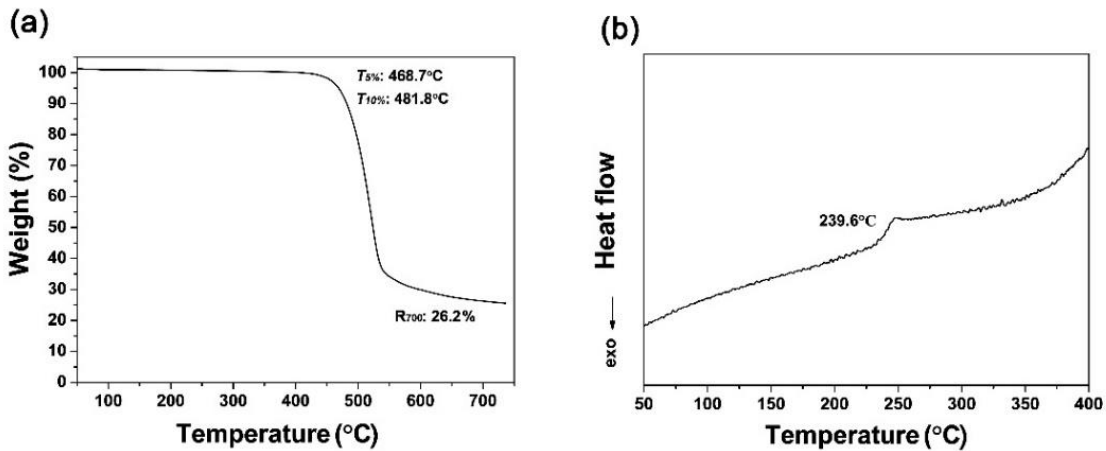
Figure 9. Thermal properties of PI-3 membrane. ( a ) TGA; ( b ) DSC.